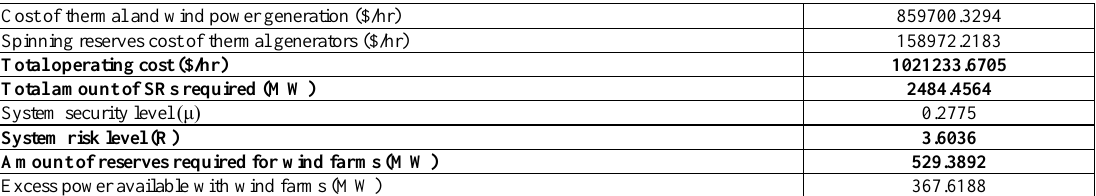
Table 2. Objective function values for Case Study 2